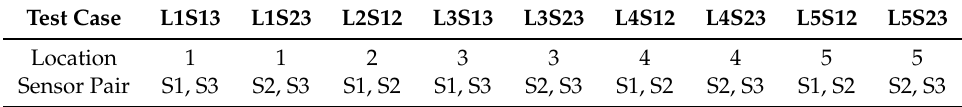
Figure 9. Pipe layout used in field measurements where S1, S2, and S3 means Sensors 1, 2, and 3; and red spots denote leak points: ( a ) Location 1; ( b ) Location 2; ( c ) Location 3; ( d ) Location 4; ( e ) Location 5. Table 3. Test cases in the field measurement.